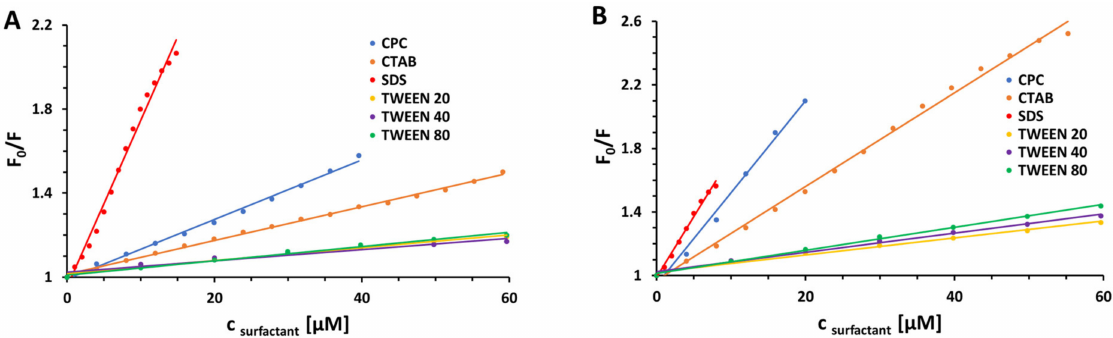
Figure 2. Stern–Volmer plots for the steady-state fluorescence quenching of BSA by different surfac- tants in 10 mM CACO buffer of pH 5.0 ( A ) and 7.0 ( B ) at 298